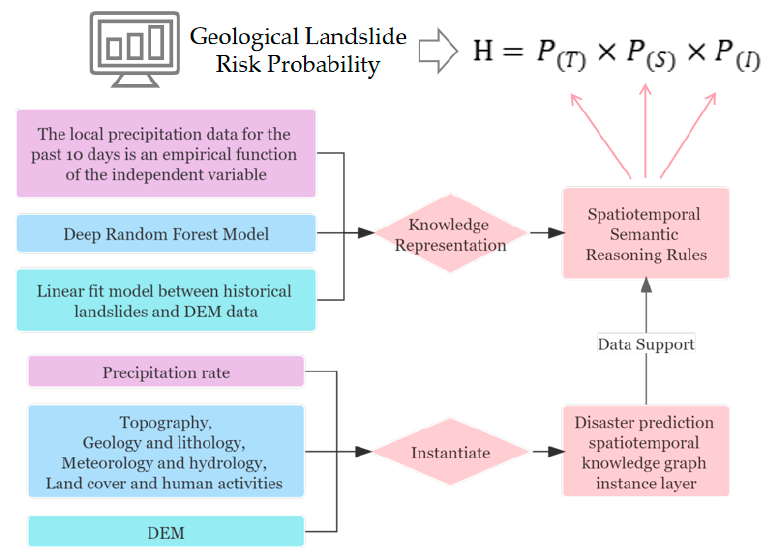
Figure 18. Geological landslide risk prediction calculation formula.